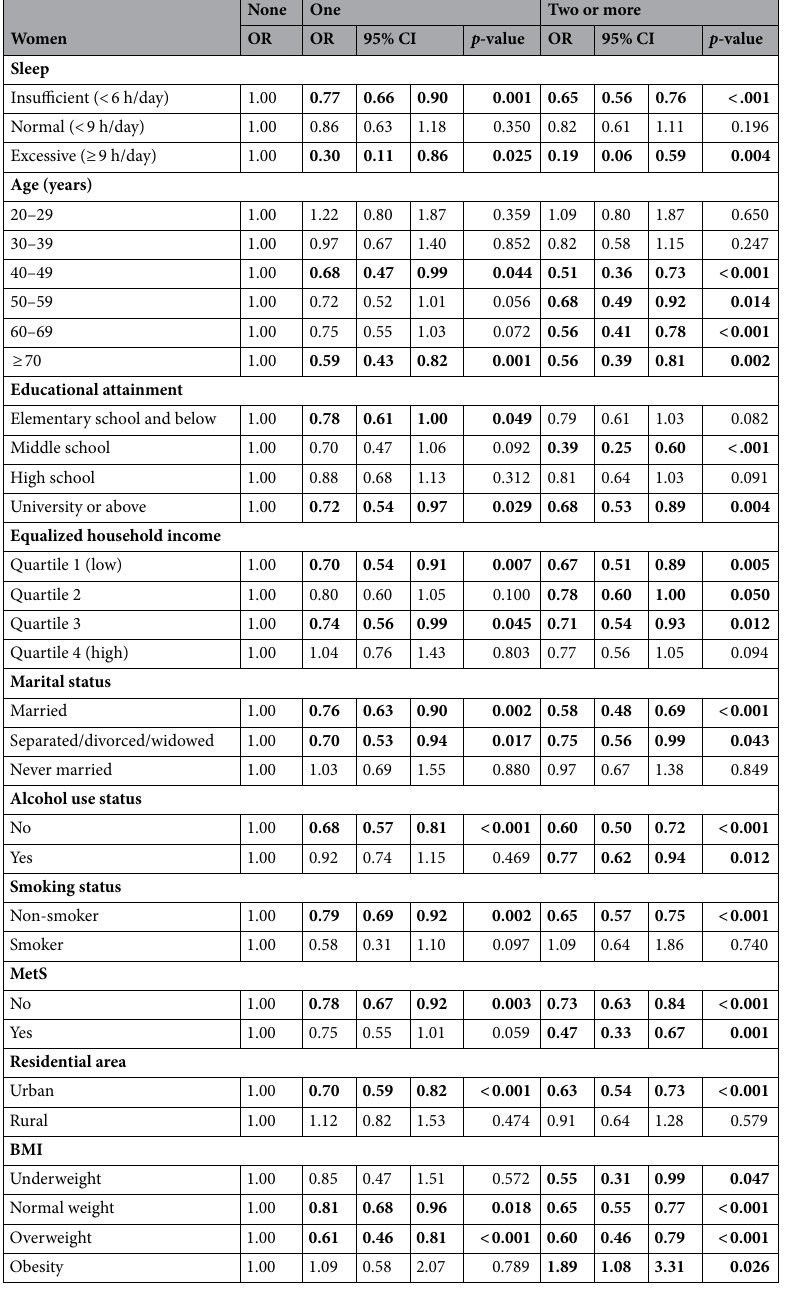
Table 4. Subgroup analysis of the association between exercise variations on depressive symptoms (PHQ-9 ≥ 5) stratified by sociodemographic variables in women. PHQ-9 patient health questionnaire-9, MetS metabolic syndrome, BMI body mass index, OR odds ratio, CI confidence interval. Bold values denote a p-value of